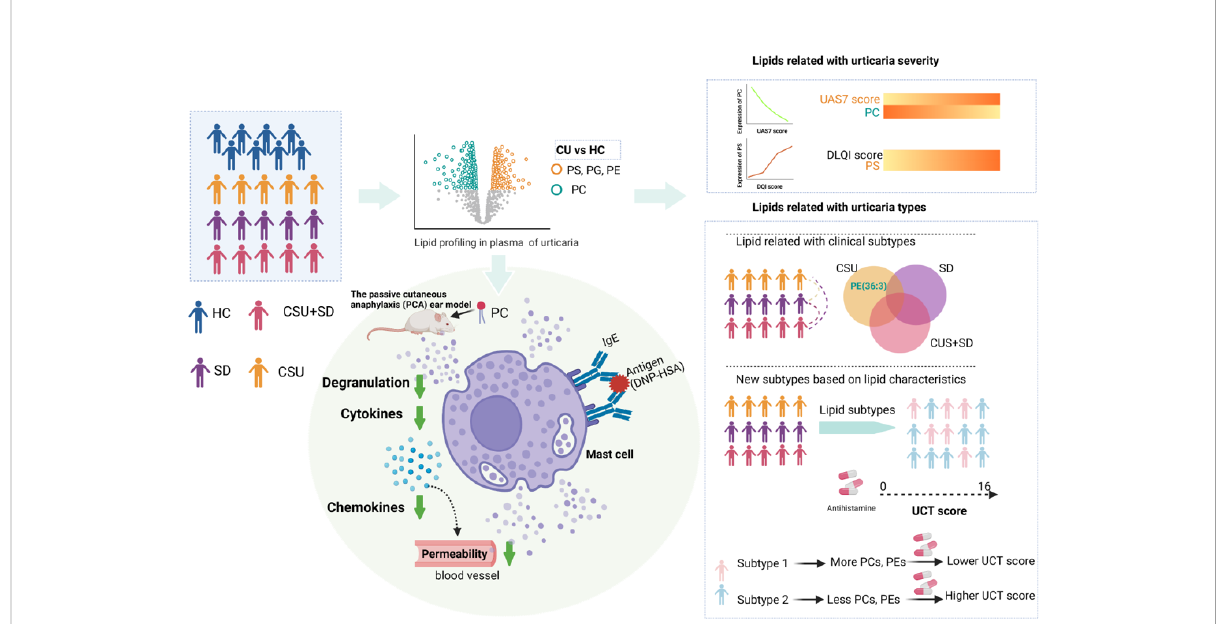
FIGURE 6 Integrative lipidomic features identify plasma lipid signatures in chronic urticaria. The lipidomics was performed to investigate the differential lipid pro fi ling between CU patients and healthy control subjects (HC). The levels of phosphatidylserine (PS), phosphatidylethanolamine (PE), and phosphatidylglycerol (PG) in CU patients were signi fi cantly increased, while those of phosphatidylcholine (PC) were signi fi cantly decreased. The decrease of PC was highly correlated with urticaria activity score (UAS7), while PS was positively correlated with dermatological quality of life index (DLQI). Differences in lipid pro fi les between CSU, SD, and CSU+SD. CU patients were divided into two subtypes, subtype 1 and subtype 2, based on consistent clustering of lipid pro fi les. Compared with subtype 2, subtype 1 was characterized by increased PC (18:0E/18:2), increased PE (38:2), and lower UCT score, indicating poor clinical ef fi cacy of second-generation H1 antihistamine therapy. PC supplementation attenuated IgE - induced mast cell immune responses in the passive cutaneous anaphylaxis model. This fi gure is created with